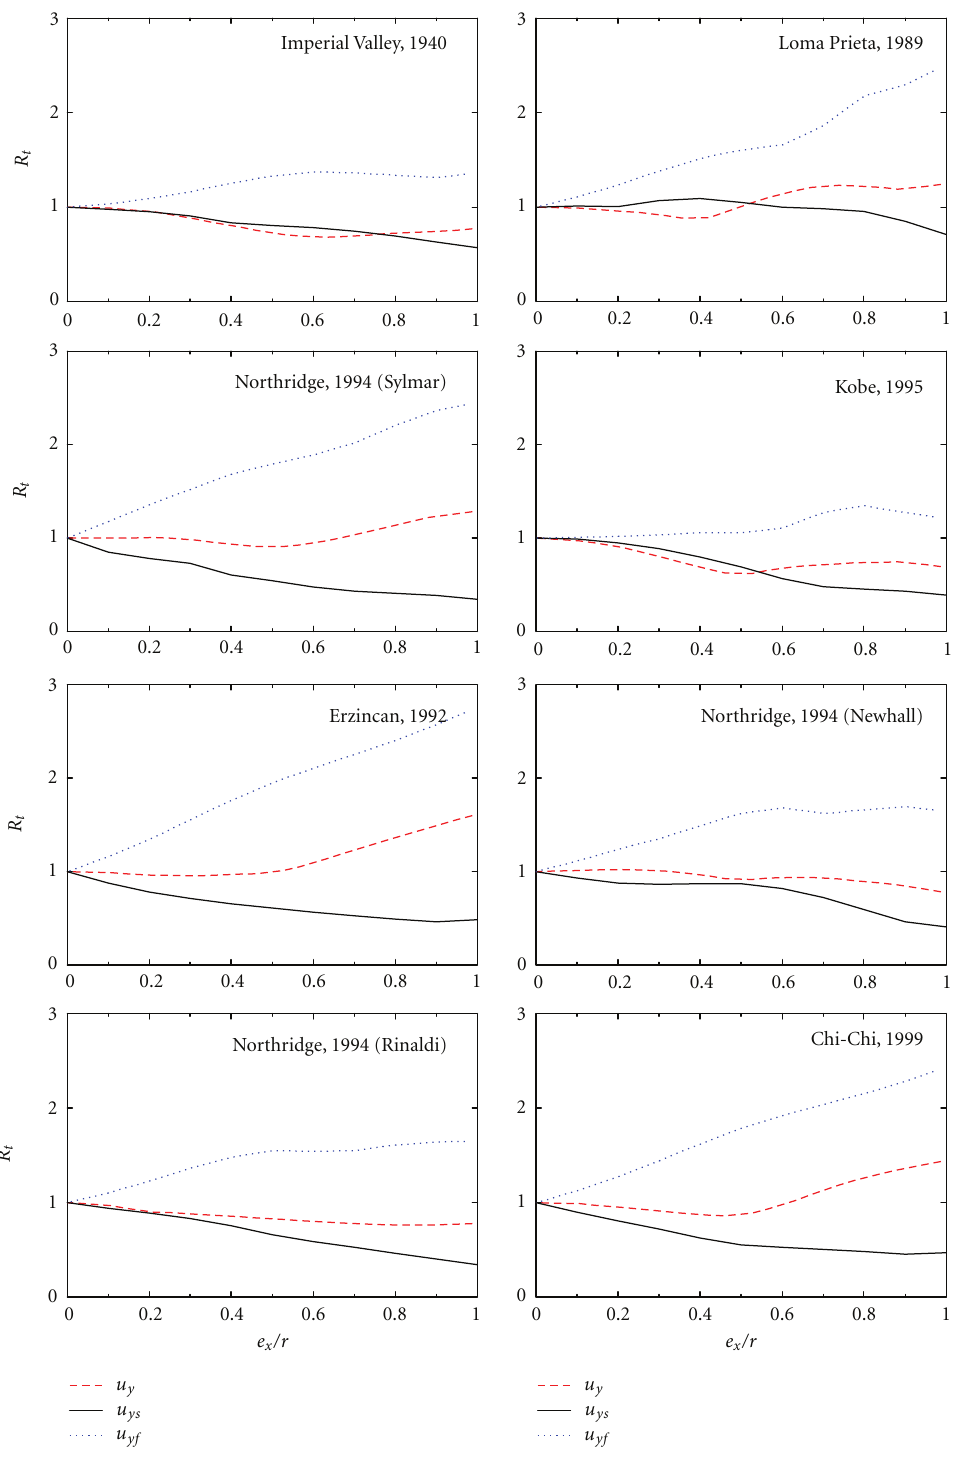
Figure 11: E ff ect of eccentricity on response ratio, R t for various peak displacements ( T y = 1 s, Ω θ =